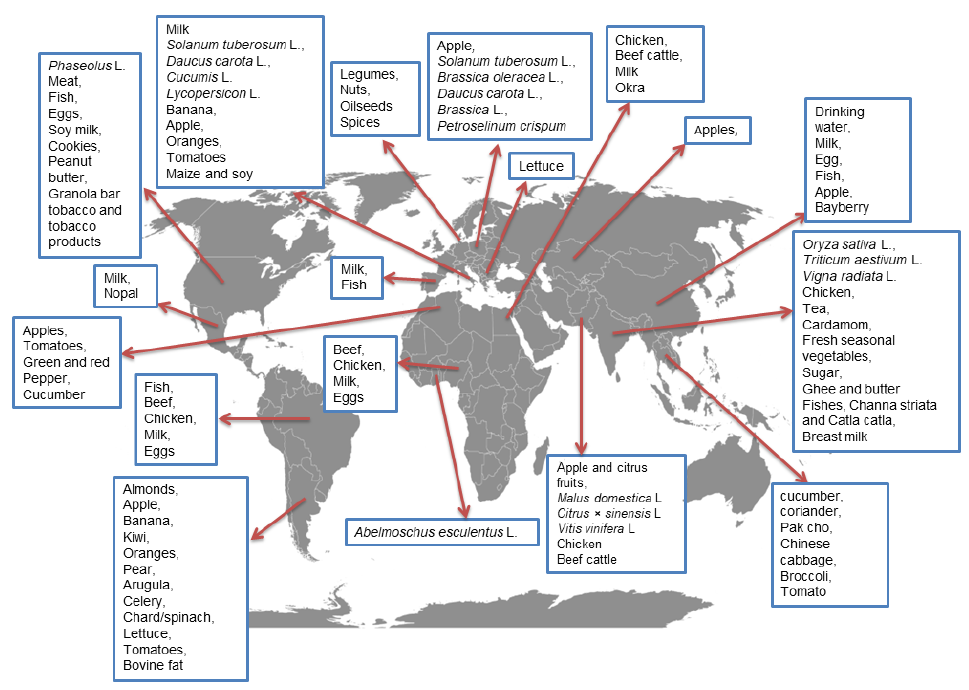
Figure 4. Occurrence of CPF residues in food in various parts of the world [37,158,166 – 168]. CPF residues were also found in chicken and cattle meat, both from a local Egypt market and imported from India and Sudan [169], and the contents of CPF ranged from 0.015 to 0.012 mg/kg. Moreover, the highest CPF concentrations in samples of beef and chicken from Brazil were, 17.5 and 0.08 μ g/ kg, respectively [170]. Due to its nutritional value, milk and milk products have a tendency to accumulate harmful chemical com- pounds. CPF residues were detected in milk in Italy, Brazil, and Mexico (0.005, 0.003, and 0.020 mg/kg, respectively) [171]. In addition, in all milk samples tested, the detection fre- quency of CPF was 76% and the highest concentration level was 45.7 μg/L [170]. In studies conducted by Hartle et al. [172], it was found that the concentration of CPF in breast milk ranged from 4.2 to 54.6 pg/g. Moreover, this milk was pasteurized and marked CPF ranged from 3.5 to 34.4 pg/g, which confirms the durability and maintenance of CPF at high values despite being subjected to preservation